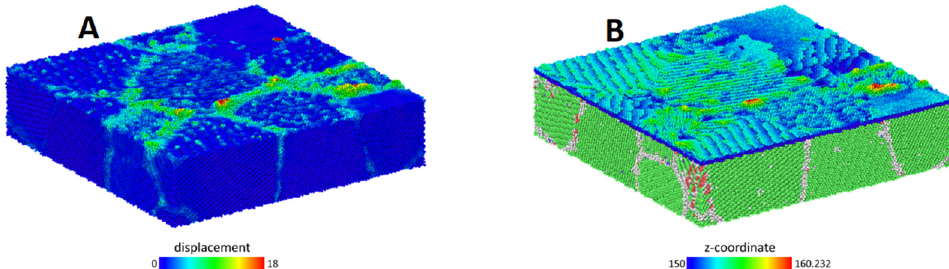
Figure 9. ( A ) Total displacement of atoms until critical surface deformation. ( B ) Height map of the surface and uderlying grain structure. It can be seen that atoms are most mobile on surface and grain boundary intersections. Only a small surface slide is shown for clarity.